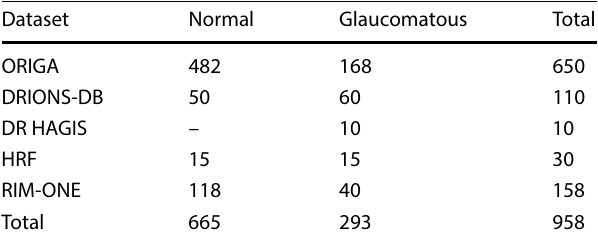
Table 3 Retinal Images Dataset distribution into Normal and Glau- comatous Images Dataset